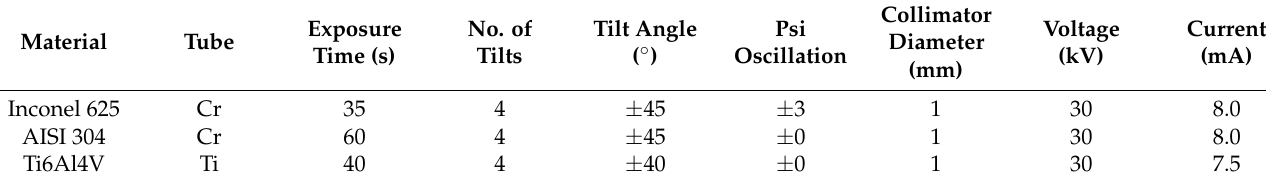
Table 3. X-ray diffraction measurement